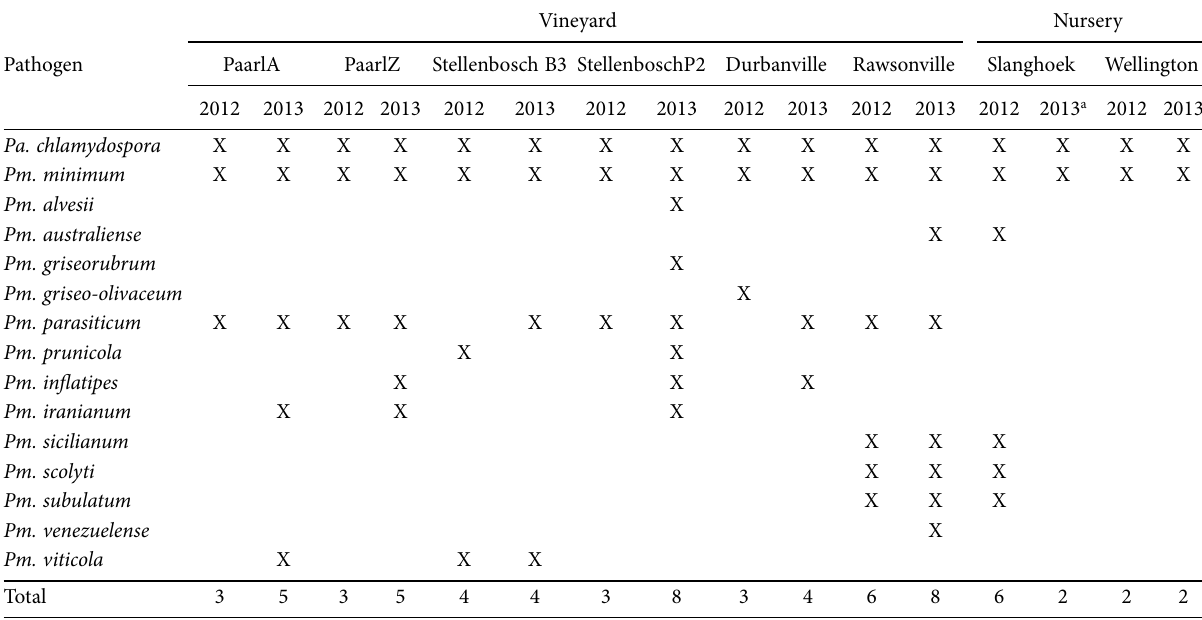
Table 4. Diversity of Petri disease pathogens collected from spore traps placed in six vineyards and two rootstock mother vine nurseries in the Western Cape Province during 2012 and 2013. (X) Denotes during which year and in which vineyard a particular species was trapped.